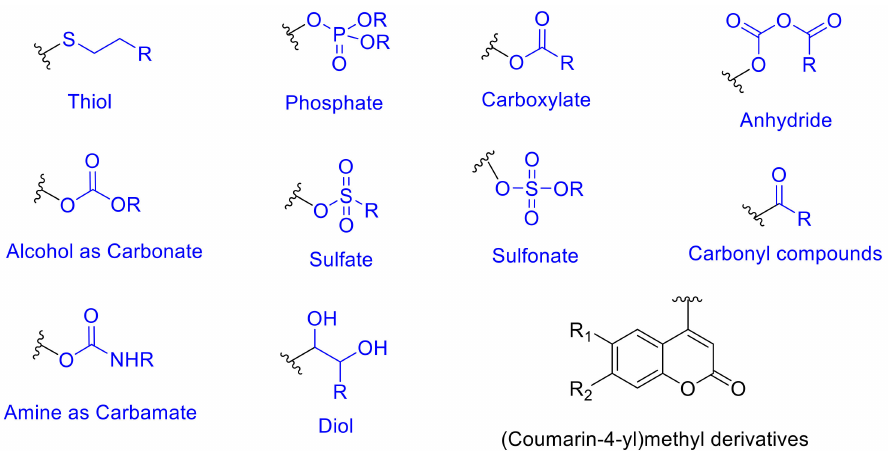
Figure 4. Coumarin-4-yl derivatives employed as caged compounds and photofuses.